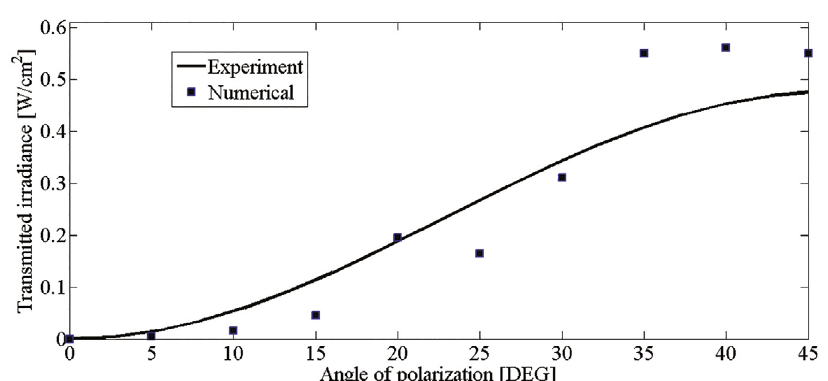
Figure 6: Nonlinear optical probe transmittance vs. angle of polarization of the interacting